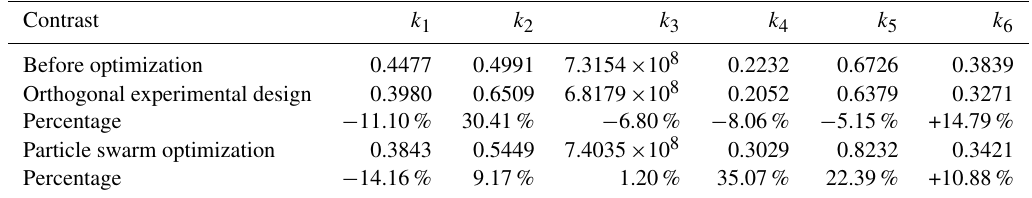
Table 7. Comparison of three traditional optimization algorithms. Contrast k 1 k 2 k 3 k 4 k 5 k 6 Before optimization 0.4477 0.4991 7.3154 × 10 8 0.2232 0.6726 0.3839 Orthogonal experimental design 0.3980 0.6509 6.8179 × 10 8 0.2052 0.6379 0.3271 Percentage − 11.10% 30.41% − 6.80% − 8.06% − 5.15% +14.79% Particle swarm optimization 0.3843 0.5449 7.4035 × 10 8 0.3029 0.8232 0.3421 Percentage − 14.16% 9.17% 1.20% 35.07%